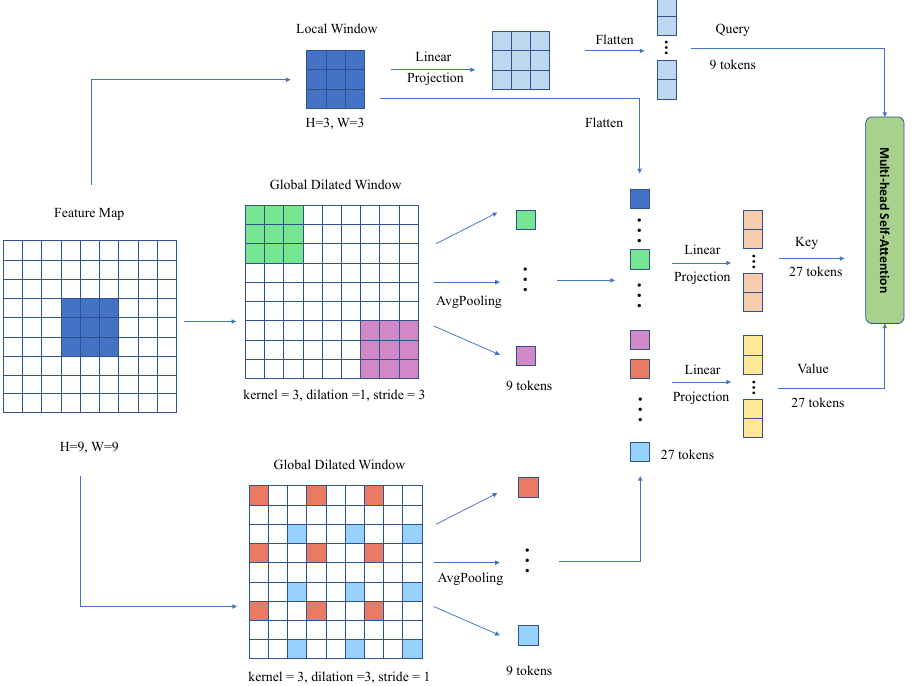
Figure 4. An illustration of the GSA module. For each window, the queries, local keys, and local values are obtained within each non-overlapping window, while the global keys and values are computed from multi-scaled dilated